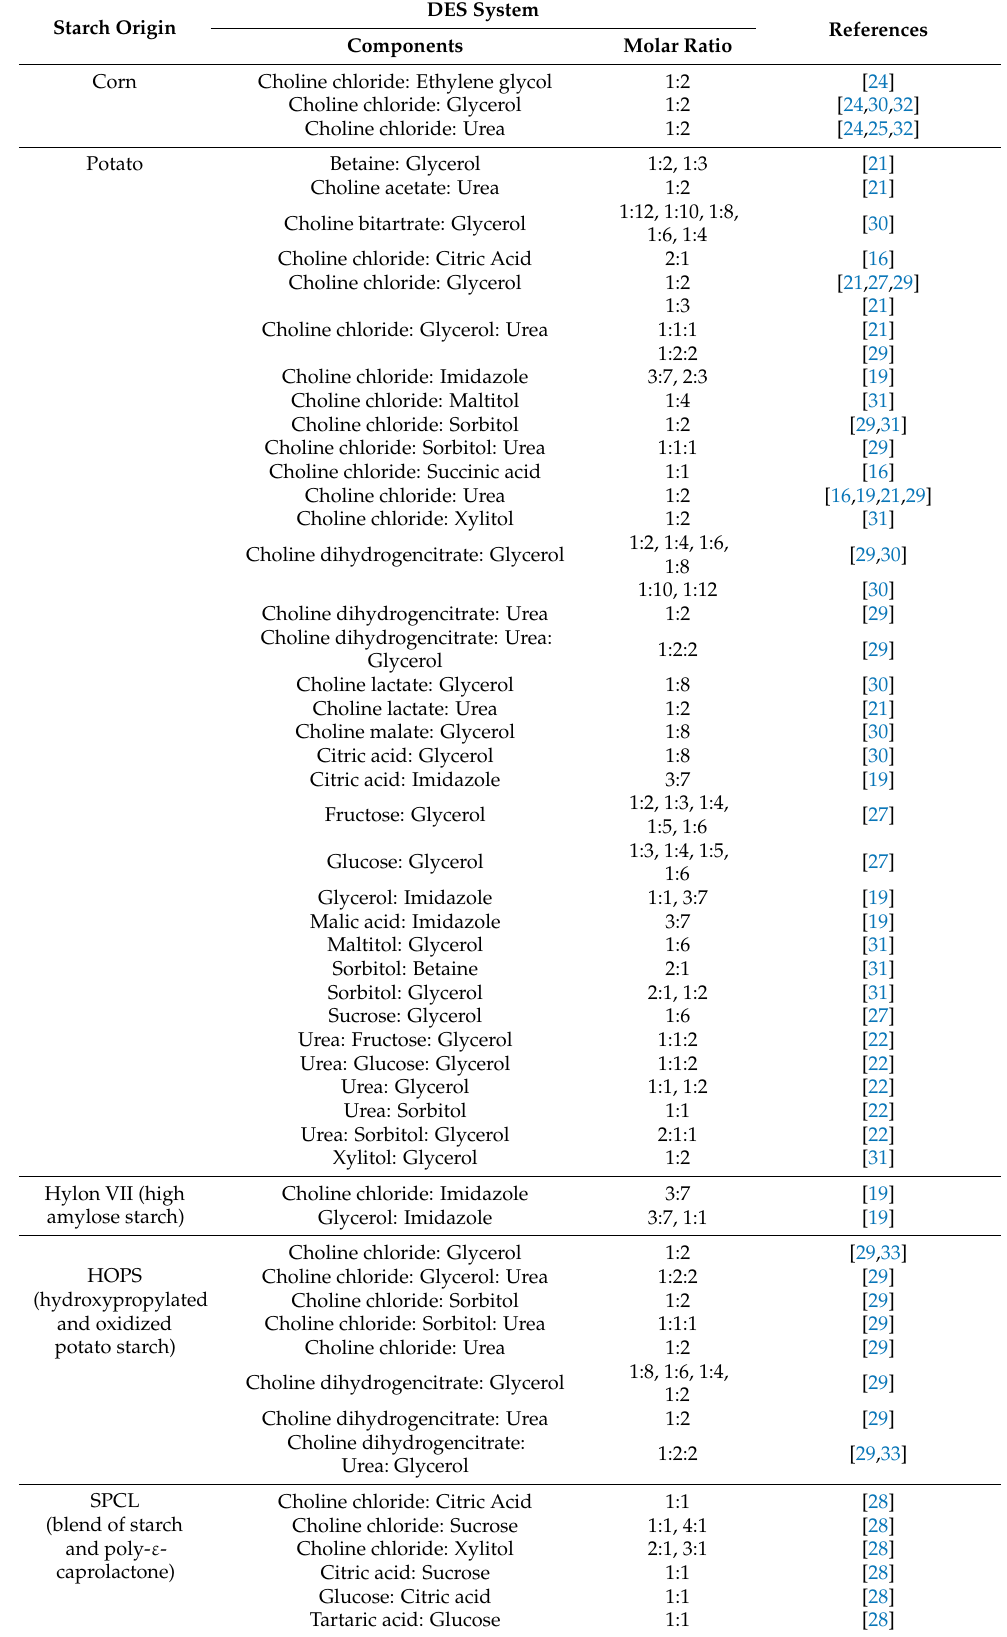
Table 2. Deep eutectic solvents used as starch